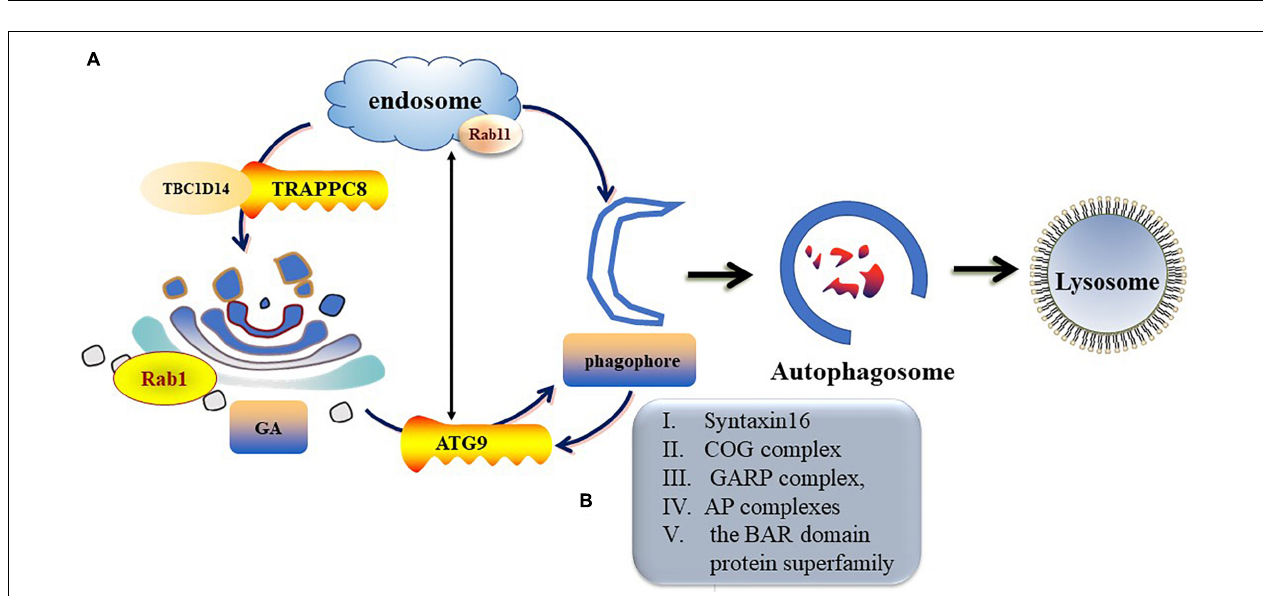
FIGURE 2 | The formation process of autophagosome. Macro-autophagy coordinates the assembly of autophagy-related (ATG) proteins to generate autophagosomes that are subsequently fused with the lysosomal membrane.